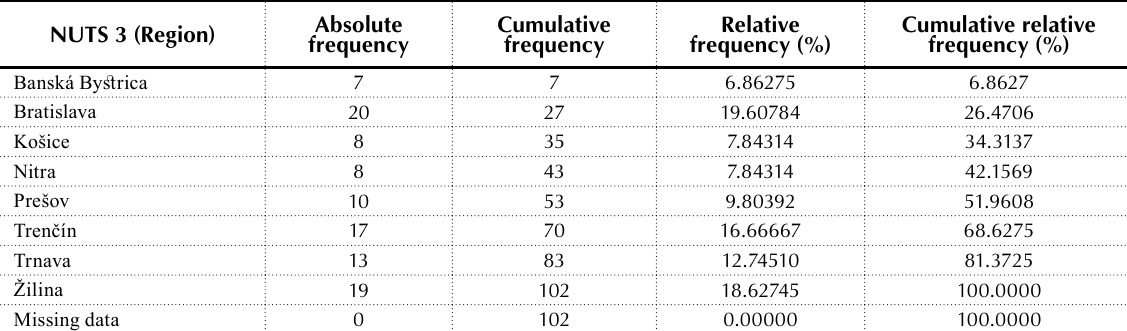
Table 2. Frequency by